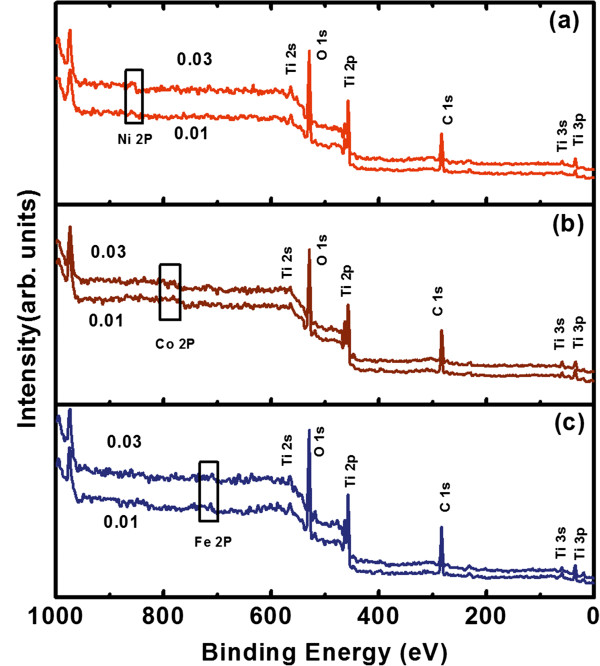
XPS survey spectra of TM-doped TiO2 thin films. (a) Ni-doped TiO2. (b) Co-doped TiO2. (c) Fe-doped TiO2.